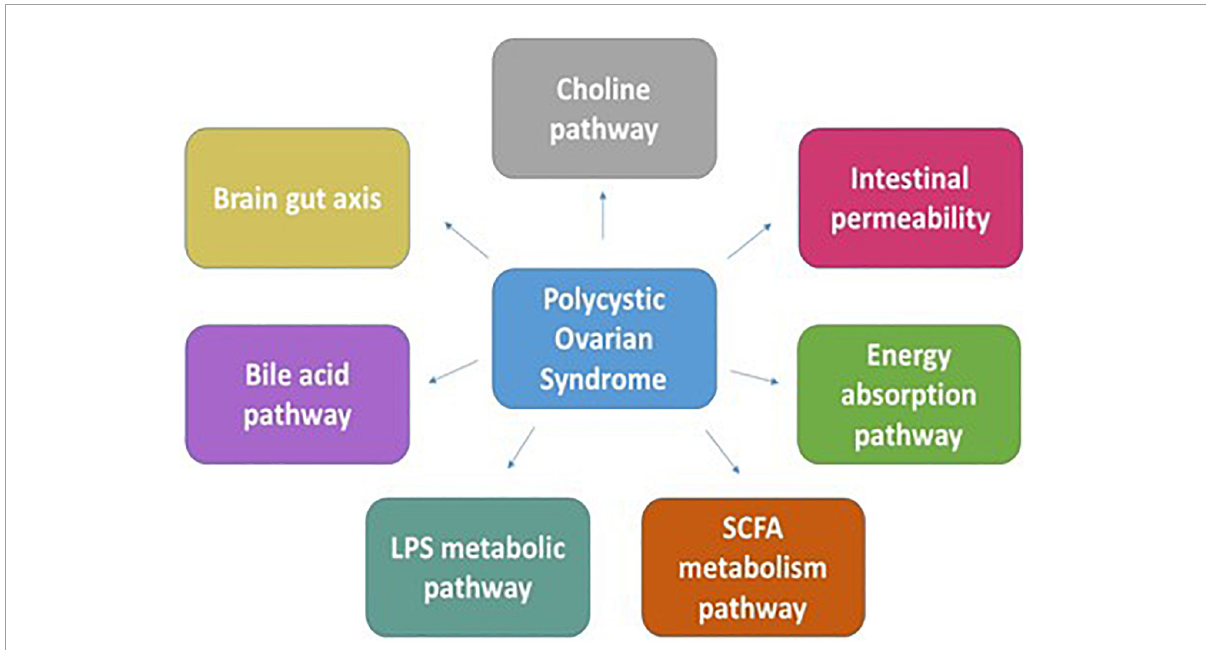
FIGURE4 The figure discusses the mechanisms pertaining to the development of PCOS through the cross talk between the genes participating in pathways such as energy absorption, carbohydrate-metabolizing pathways, bile acid pathway, SCFA, and LPS metabolic pathways with the dysbiotic gut